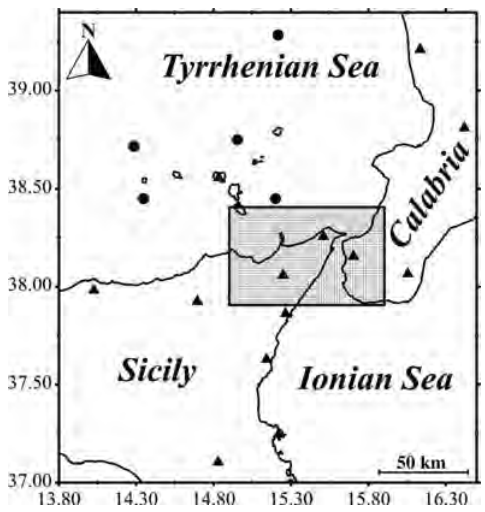
Fig. 6. Network configurations used for tests per- formed with synthetic earthquakes in order to assess the hypocentral location quality. Triangles and cir- cles mark the land and sea-bottom stations. The inte- grated network (configuration LS ) included both sets of stations. The land stations constitute the network configuration L . Hypocenters of synthetic earth- quakes were positioned on a 3D grid, with horizon- tal spacing of 1.5 km and vertical spacing 5 km from the Earth surface down to 35 km. The gray rectangle indicates the area selected for the synthetic